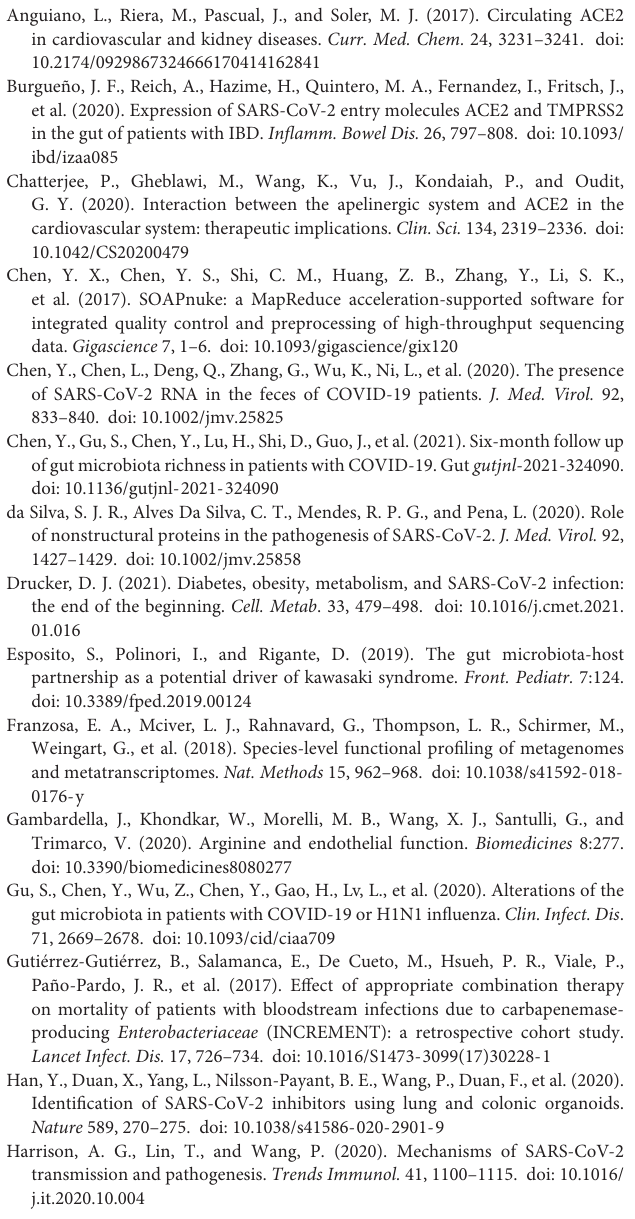
Supplementary Table S5 | Gut microbial compositions at genus level of the discovery cohort ( n = 37). Supplementary Table S7 | Correlation analysis of 15 gut microbial markers with various clinical indices of COVID-19. Supplementary Table S8 | Relative abundance of gut microbiota at the genus level in the different clinical types of COVID-19. Supplementary Table S9 | Relative abundance of gut microbiota at the species level in the different clinical types of COVID-19. Supplementary Table S10 | Sequencing information of 66